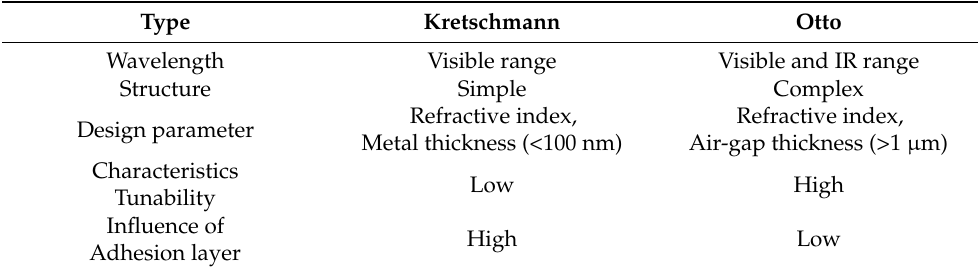
Figure 1. Prism coupling configurations used in SPR systems: ( a ) Kretschmann configuration; ( b ) Otto configuration. Table 1. Sensor characteristics of Kretschmann and Otto configurations.